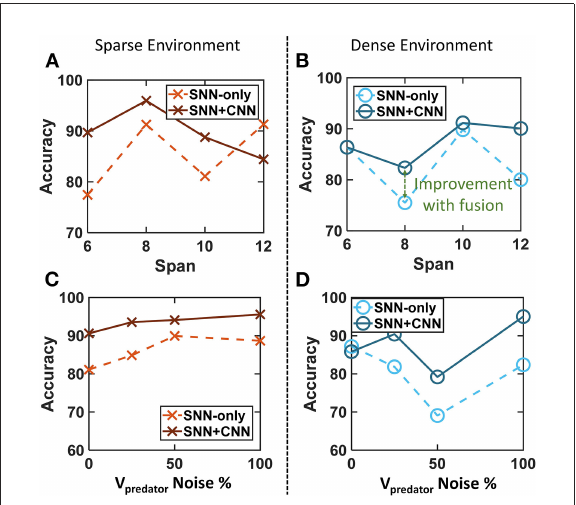
FIGURE10 Tuning the empirical parameters for SNN filter and fusion algorithm. (A,B) Target localization accuracy with a varying span of connectivity for both sparse and dense environments. The span of 10 is used for higher accuracy. (C,D) Target localization accuracy while varying the induced noise in the predator’s velocity for both sparse and dense environments. The final fused accuracy is robust to noise in